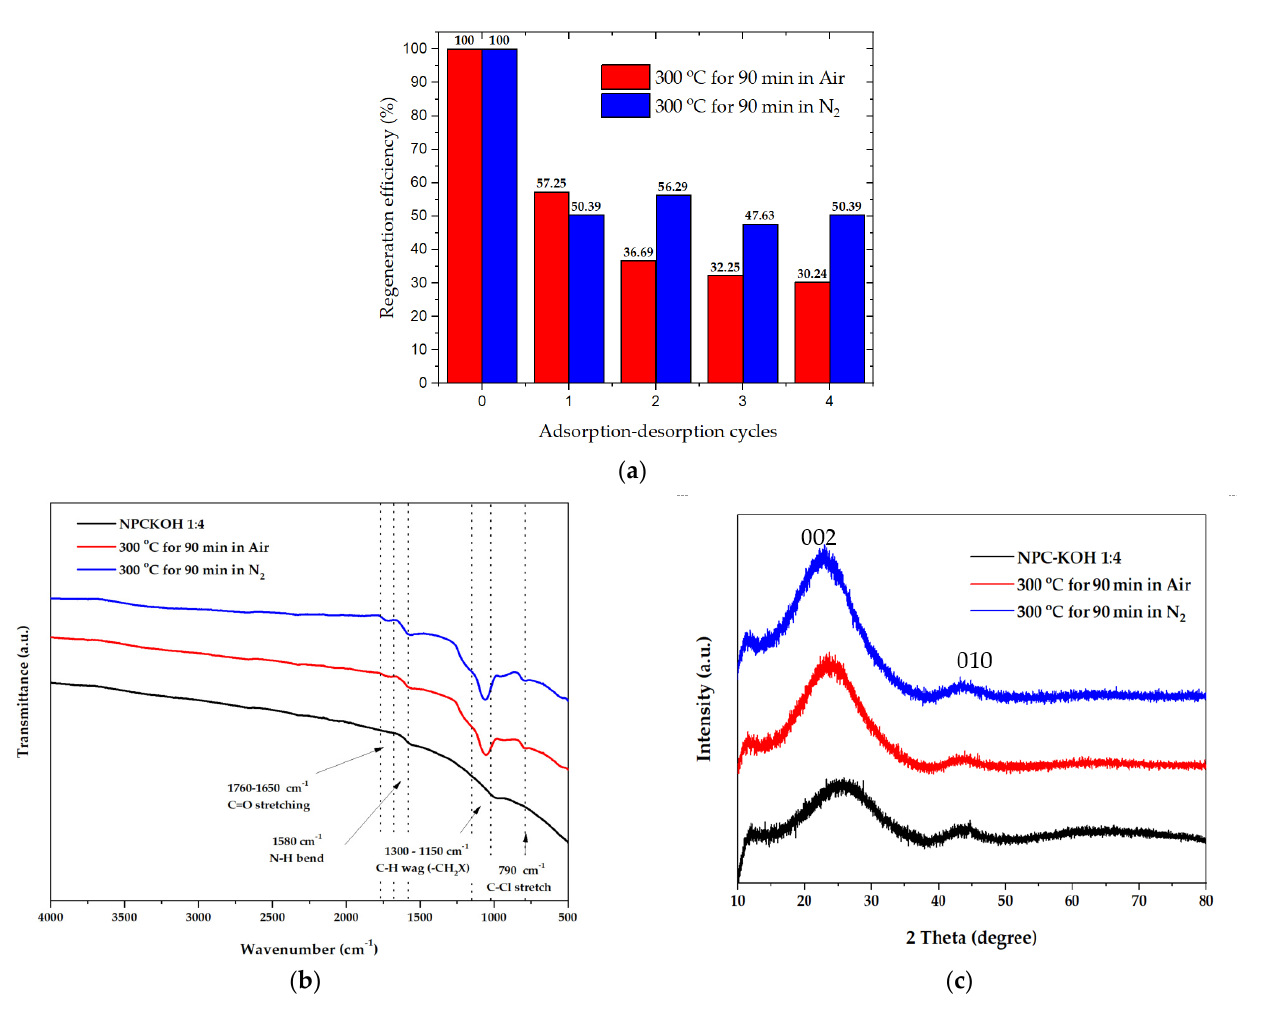
Figure 12. ( a ) Regeneration efficiency of the material with paraquat after four adsorption–desorption cycles.; ( b ) FTIR spectra of the material with paraquat after four adsorption–desorption cycles.; ( c ) XRD patterns of the material with paraquat after four adsorption–desorption cycles. The concen- tration of paraquat solution was 200 mg · L − 1